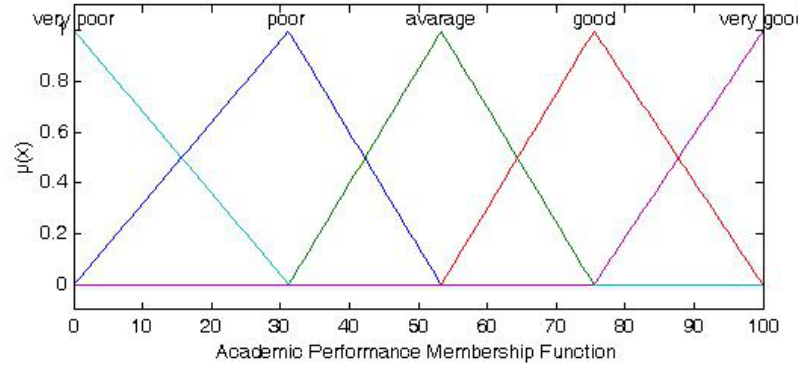
Figure 7 . Membership function for the output